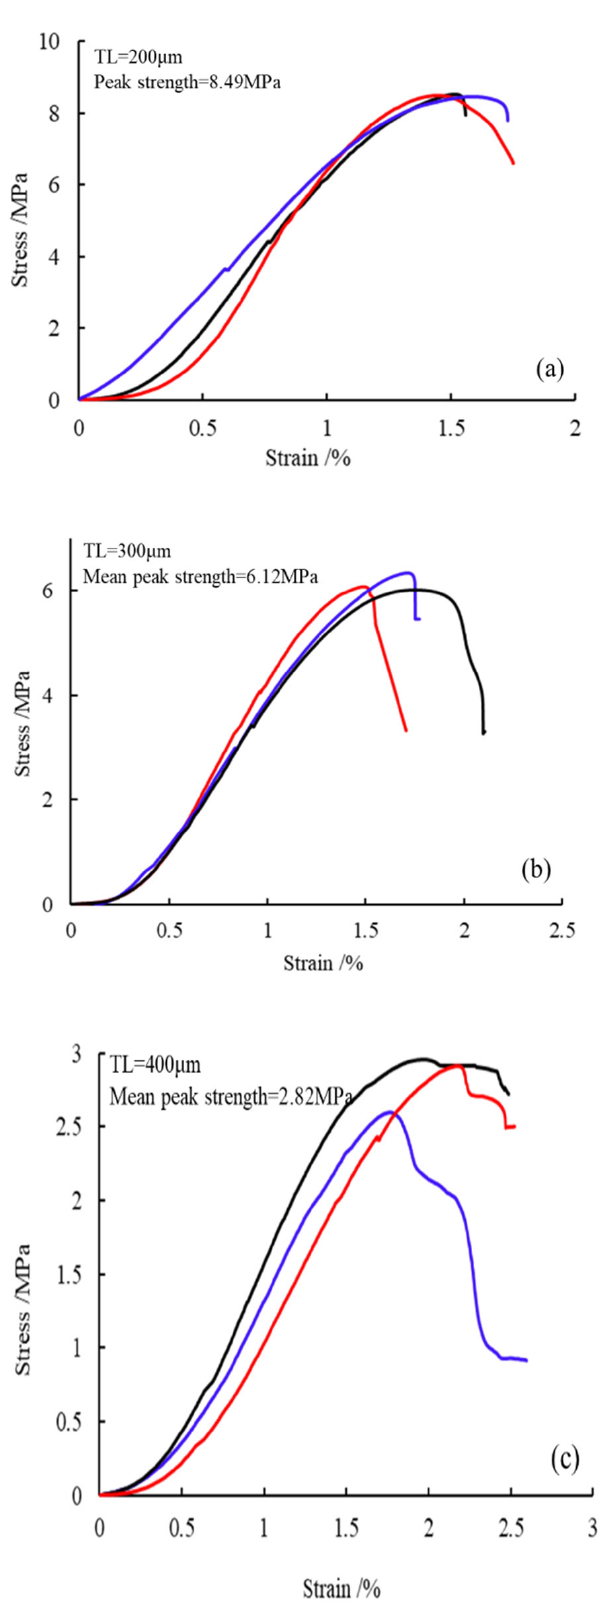
Figure 11. Stress–strain curves of the 3DP rock analogs printed with different LTs: ( a ) 200 µ m, ( b ) 300 µ m, ( c ) 400 µ m.